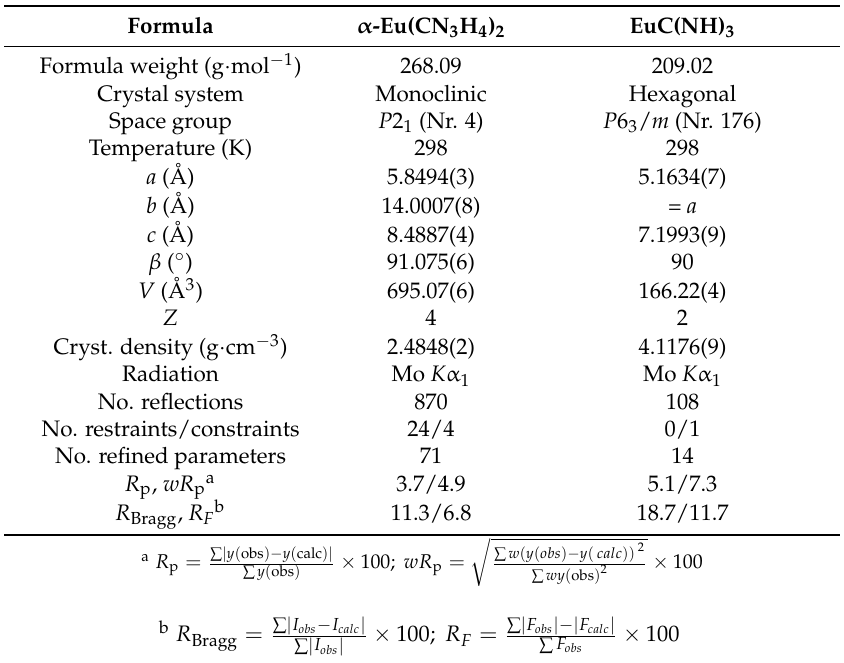
Figure 4. Rietveld refinement of α -Eu(CN 3 H 4 ) 2 with a minor side phase of EuO measured with Mo K α 1 radiation. Table 2. Crystallographic data and refinement details for EuC(NH) 3 and α -Eu(CN 3 H 4 ) 2 .